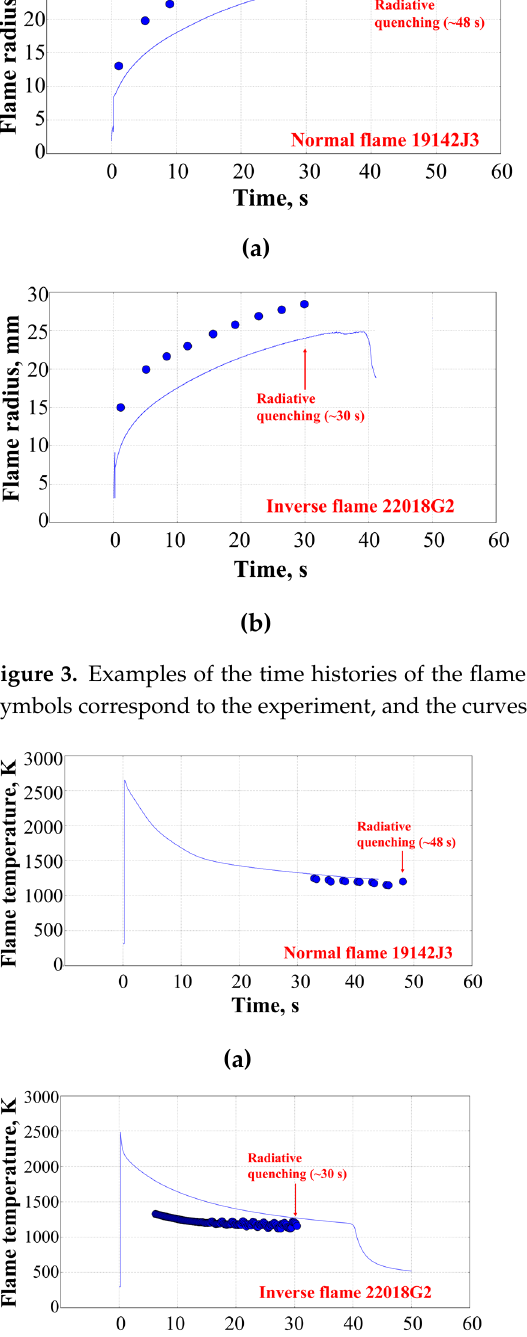
Figure 4. Examples of the time histories of the flame temperature: ( a ) normal flame; ( b ) inverse flame. Symbols correspond to the experiment, and the curves correspond to the calculation.